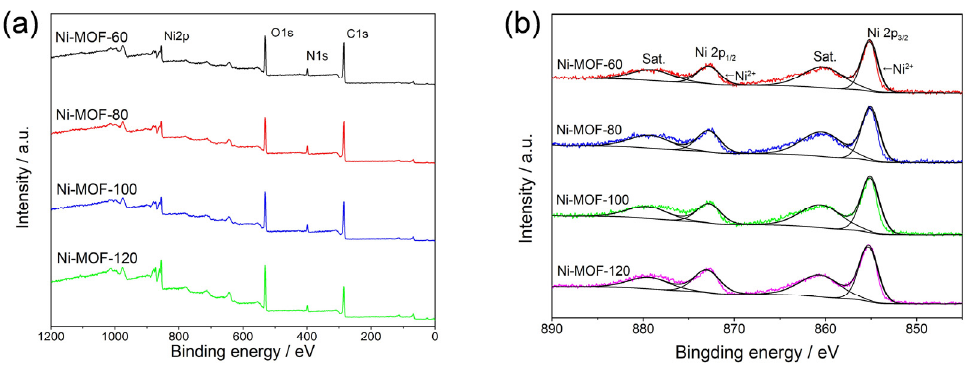
Figure 3. ( a ) Full XPS spectra and ( b ) Ni spectra of Ni-MOF-60, Ni-MOF-80, Ni-MOF-100, and Ni-MOF-120.